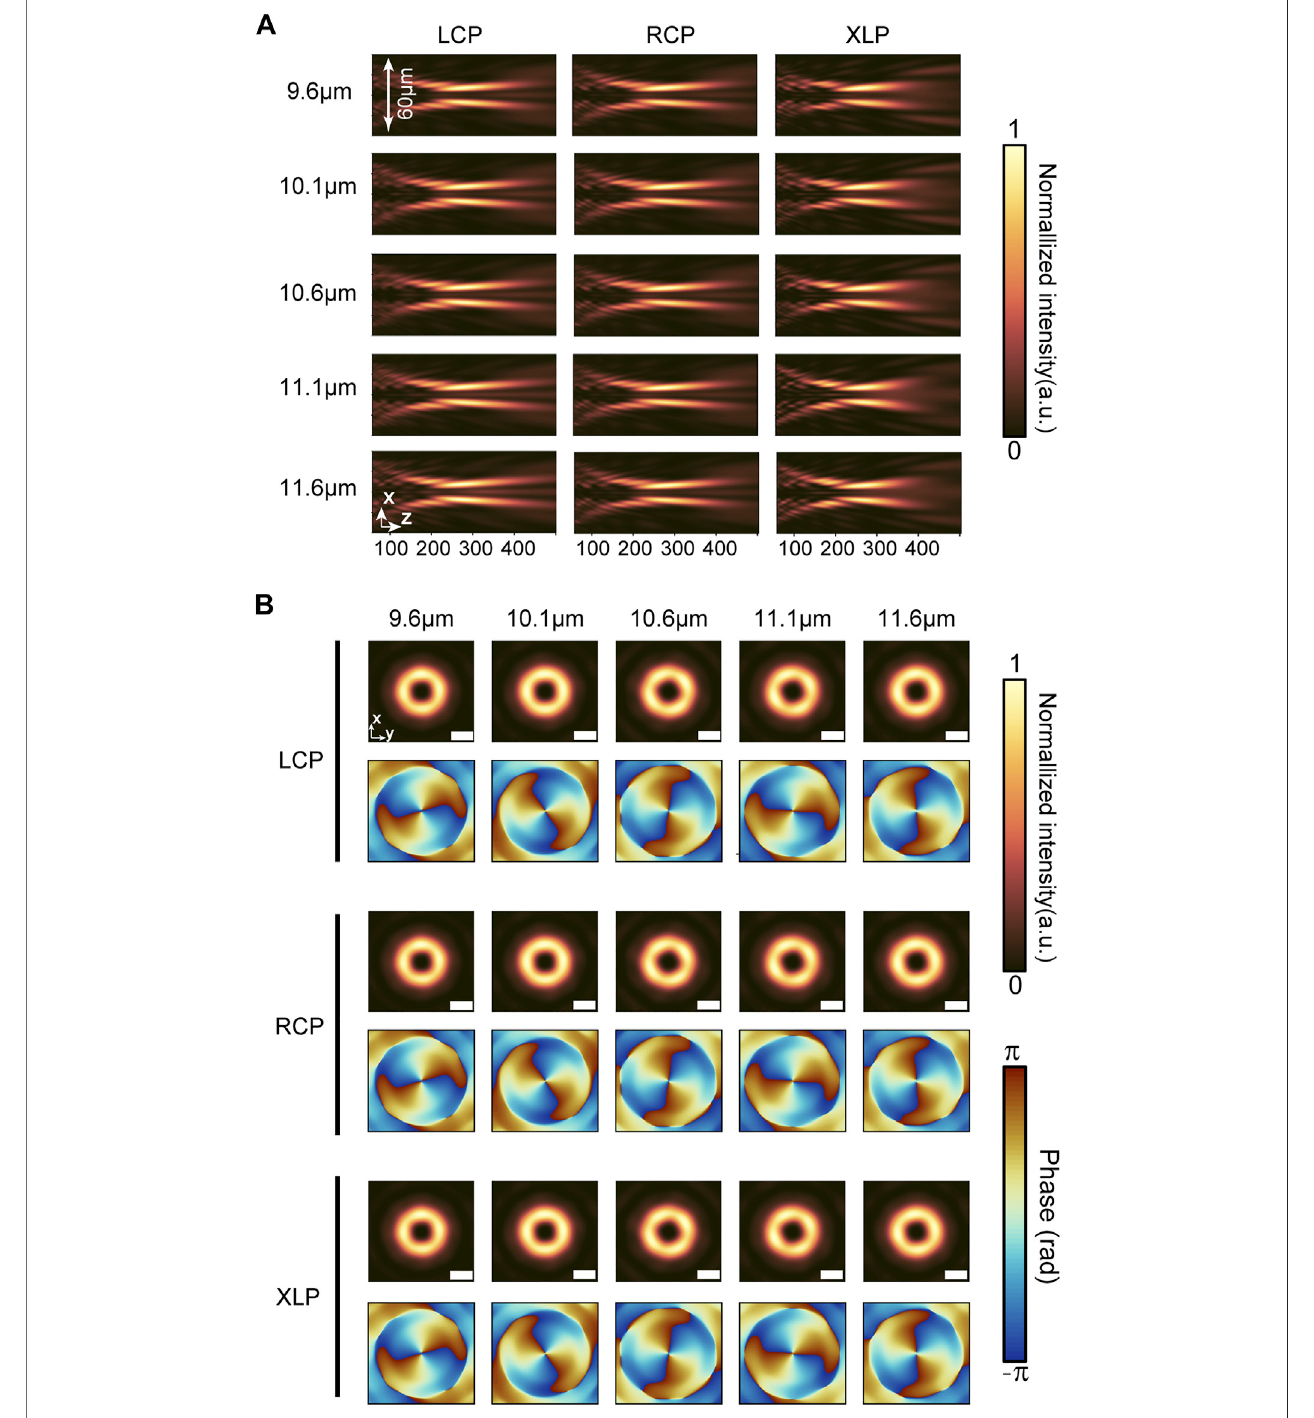
FIGURE 7 | Intensity and phase distributions for the FOV generator. (A) Intensity pro fi les in the x - z plane at selected wavelengths. From left to right, each column corresponds to LCP incidence, RCP incidence, and XLP incidence. (B) Intensity pro fi les and phase pro fi les at the focal plane at selected wavelengths. From top to bottom, each column corresponds to LCP incidence, RCP incidence, and XLP incidence. Scale bar is 10 µm.